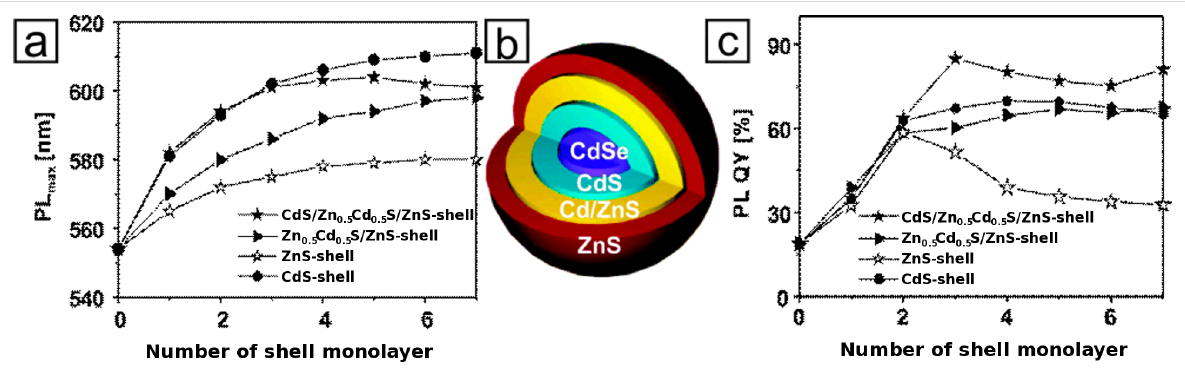
Figure 2: a) Evolution of the PL-peak position, b) schematic representation, and c) evolution of the PL-quantum yield for several core-shell quantum dots starting with a CdSe core. Adapted with permission from [13]. Copyright 2005 American Chemical Society.